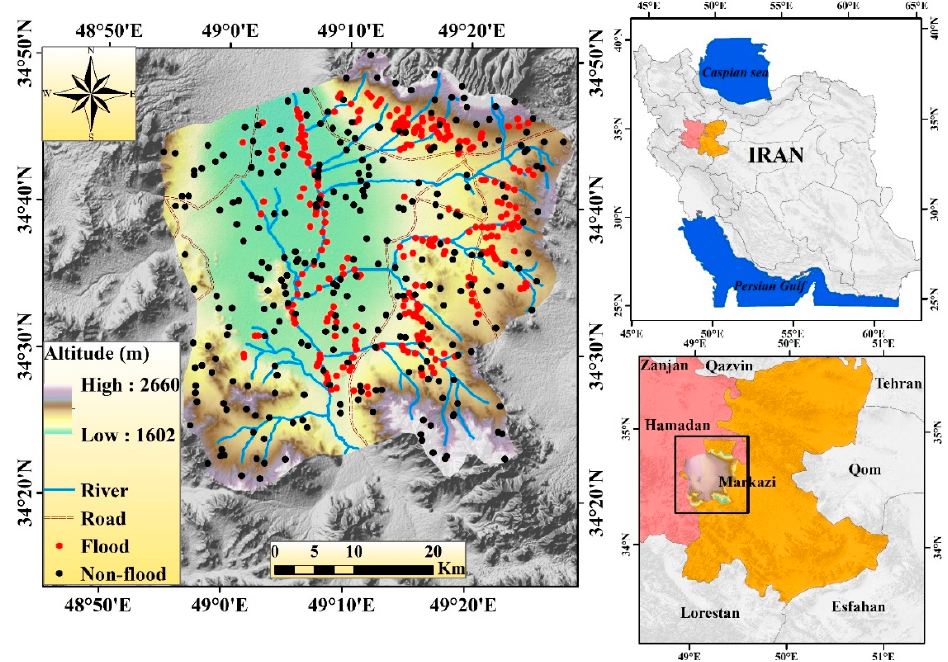
Figure 1. Location of the Kalvan watershed in Markazi and Hamadan Province, Iran.